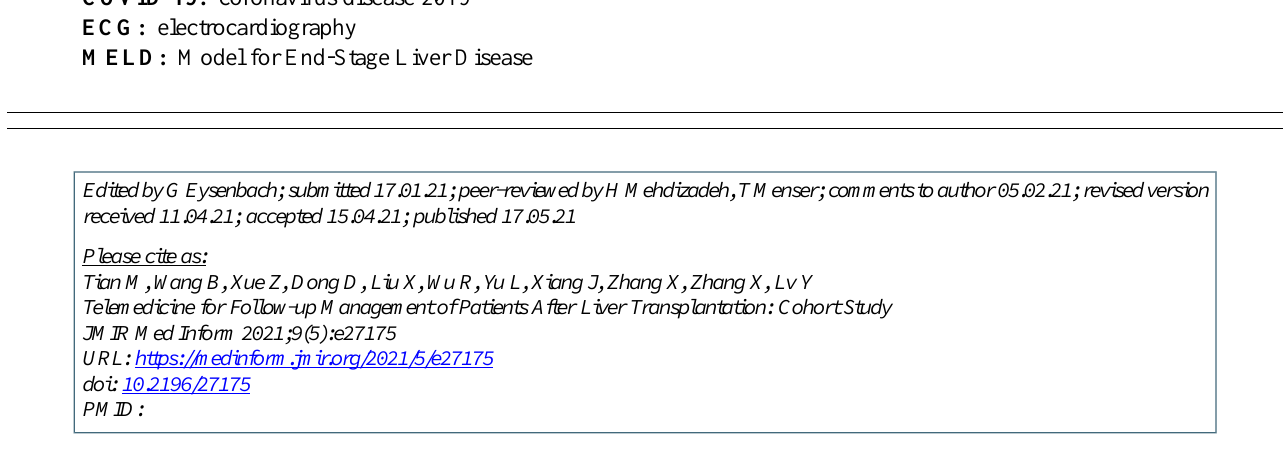
ECG: electrocardiography MELD: Model for End-Stage Liver